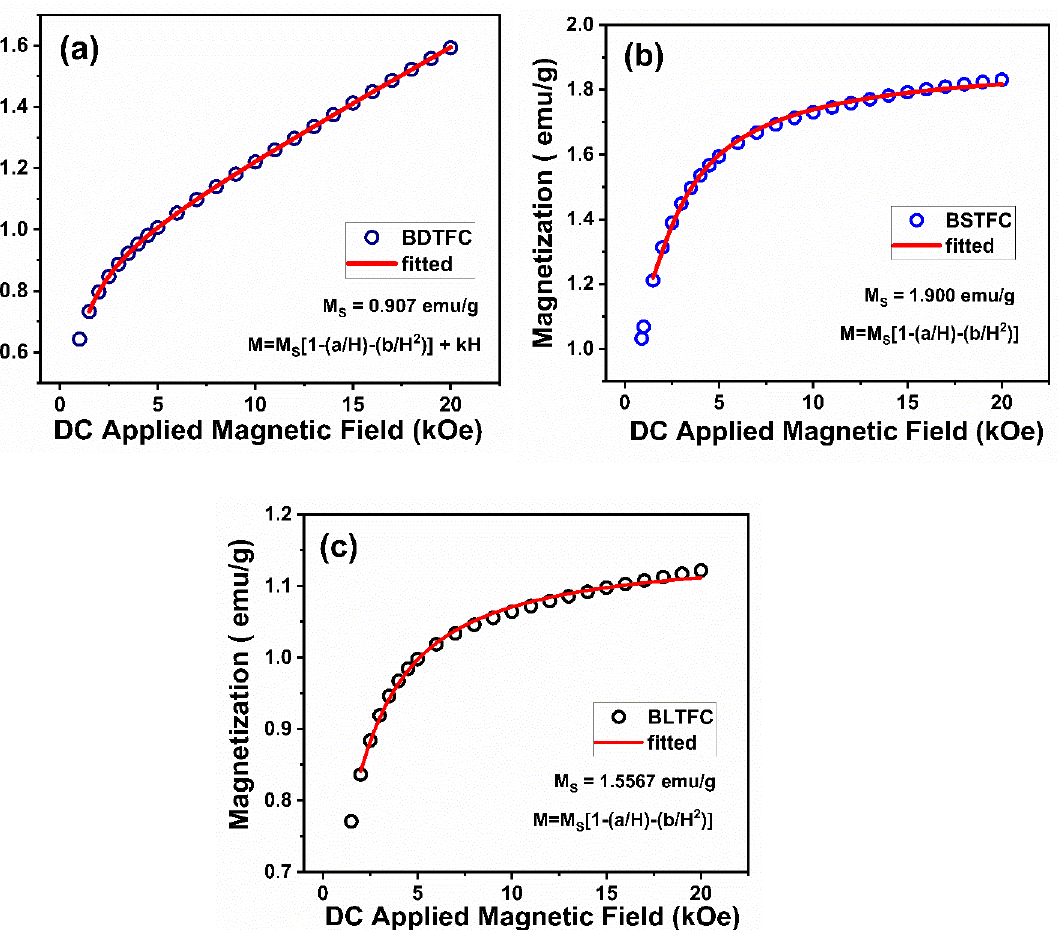
Figure 7. ( a − c ) Law of approach to saturation fittings M vs H curves of BDTFC, BSTFC, and BLTFC Figure 7. ( a – c ) Law of approach to saturation fittings M vs. H curves of BDTFC, BSTFC, and samples. BLTFC